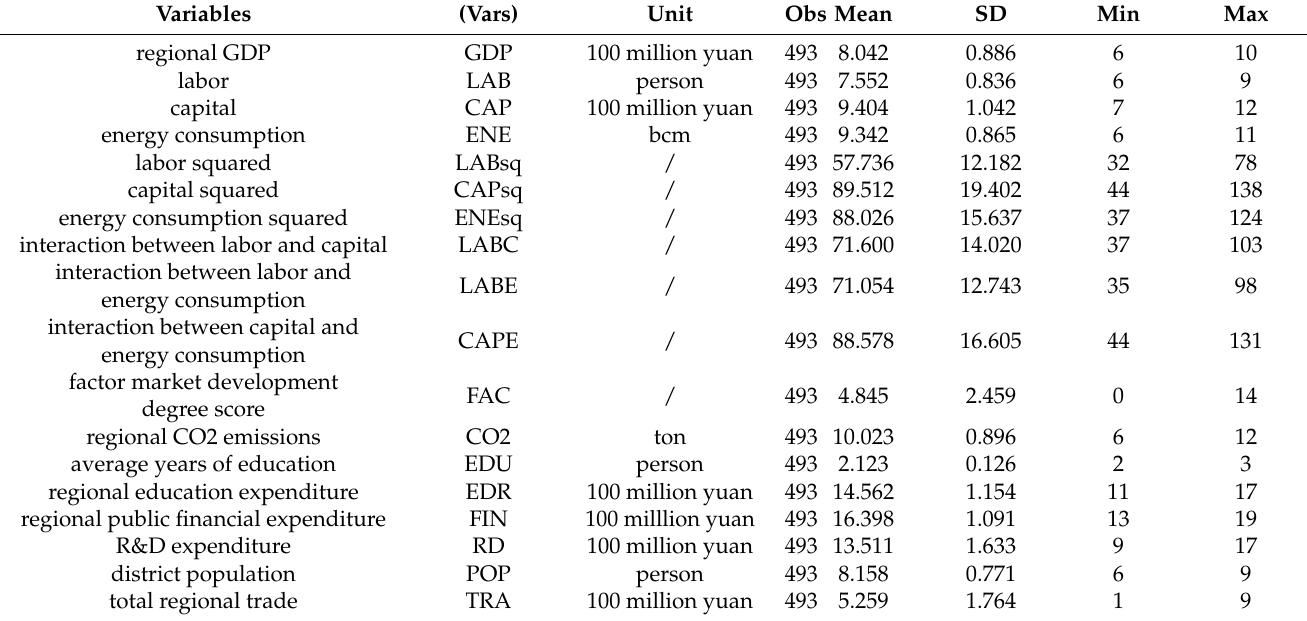
Table 1. Descriptive statistical summary of variables.